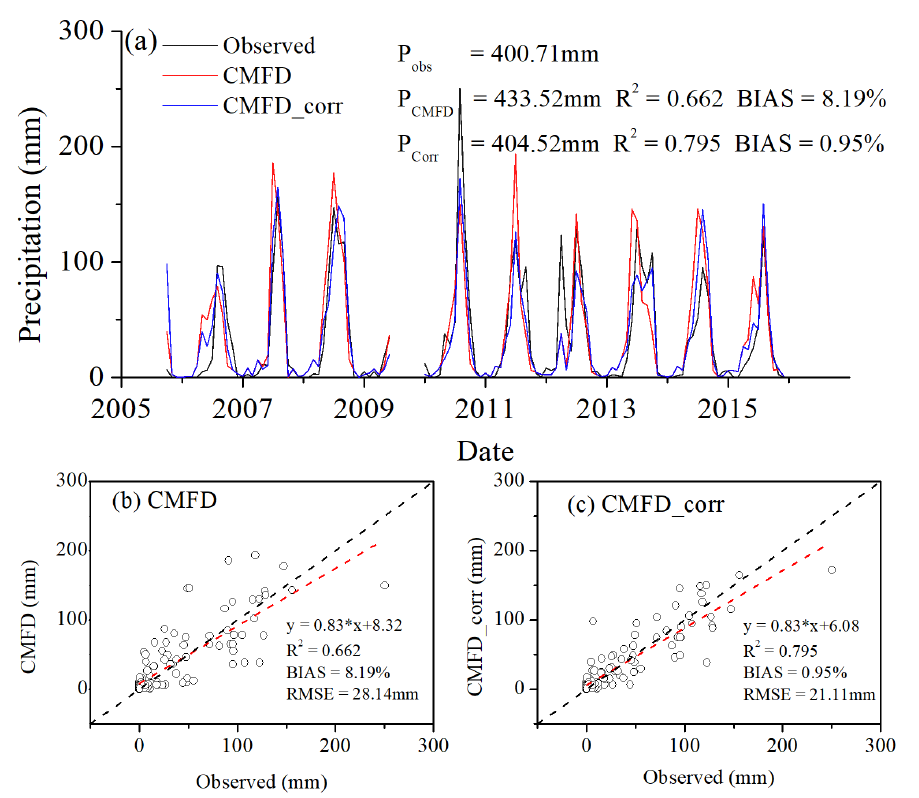
Figure 3. Comparisons of the original and corrected CMFD precipitation data with the observed precipitation at the Nam Co Monitoring and Research Station for Multisphere Interactions. Time-series ( a ), scatterplots of the observations and original CMFD data ( b ) and scatterplots of the observations and the corrected CMFD data ( c ) were given respectively.